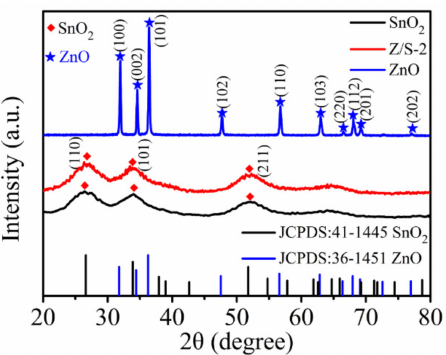
Figure 3. XRD patterns of ZnO, SnO 2 , and Z/S-2